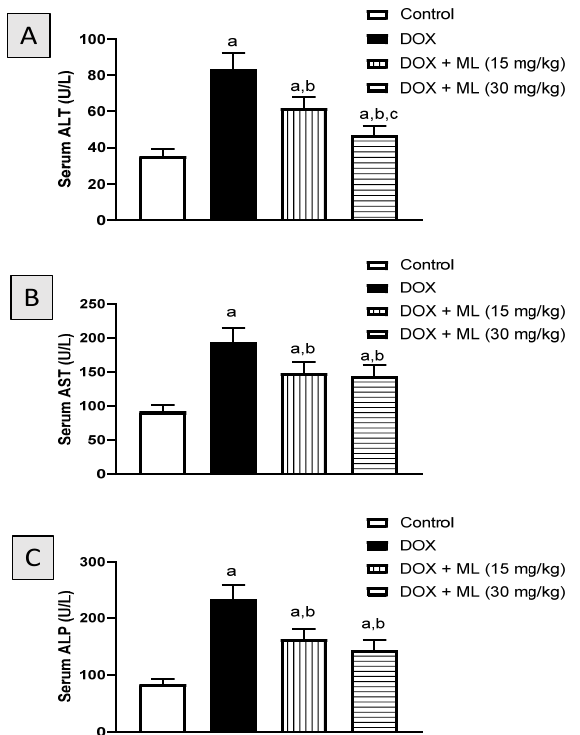
Figure 3. Effect of ML on serum markers of hepatotoxicity induced by DOX in rats. ( A ): Serum ALT activity, ( B ): Serum AST activity, ( C ): Serum ALP activity. Data are presented as Mean ± SD (n = 6). a: Significantly different from Control at p < 0.05; b: Significantly different from DOX at p < 0.05; c: Significantly different from DOX + ML (15 mg/kg) at p < 0.05.